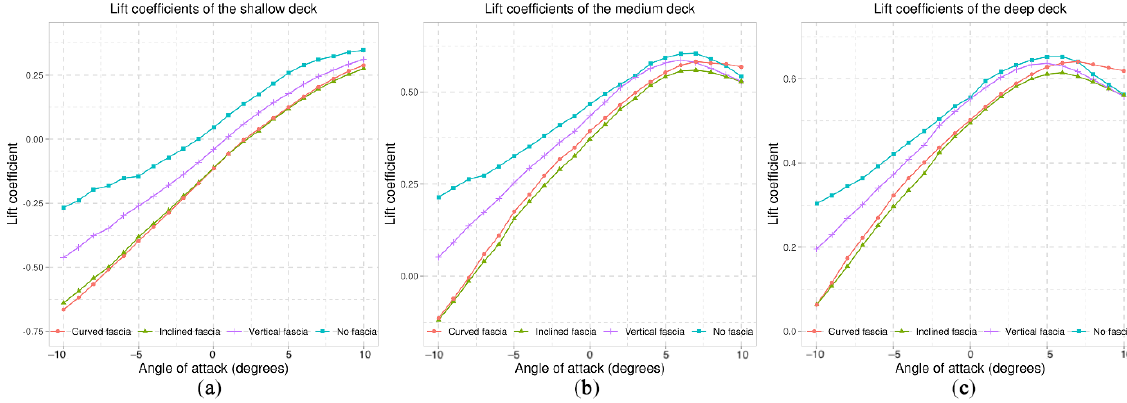
Figure 25. Change in lift coefficient for each fascia beam for the ( a ) shallow deck, ( b ) medium deck, and ( c ) deep deck.